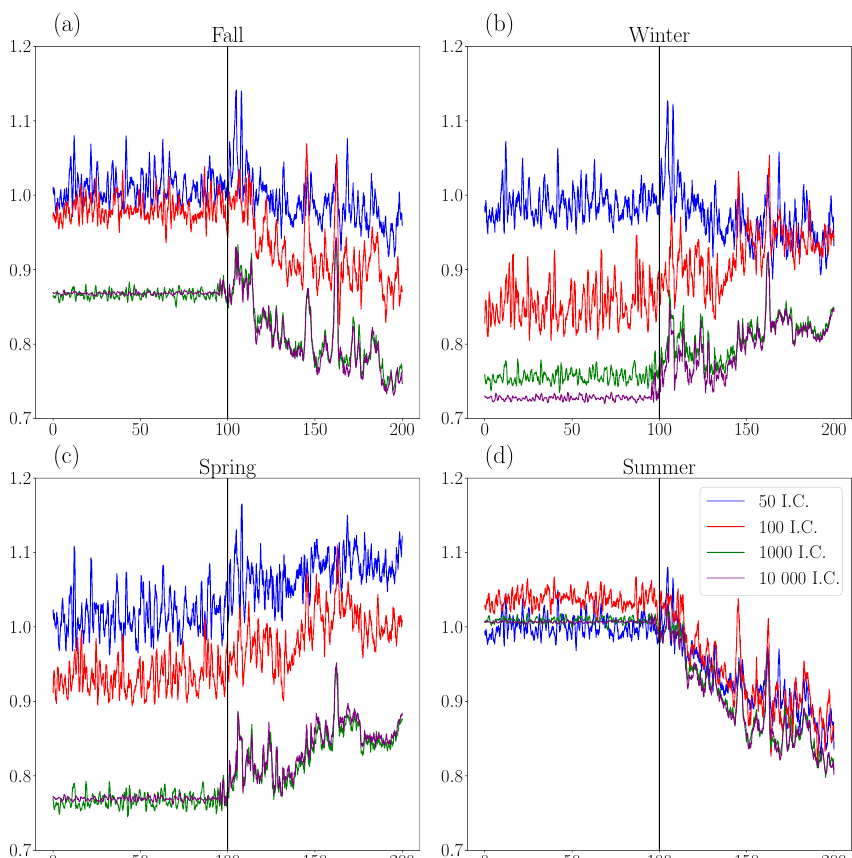
Figure 6. Yearly averages Wasserstein distance between the reference attractor before forcing, and all other attractors. The x axis is the time, the y axis the estimated Wasserstein distance. The blue (resp., red, green and purple) is the numbers of initial conditions (I.C.) for N (resp., 100, 1000 and 10000). The vertical black line represents the instant when the linear trend is triggered in the forcing F(t)